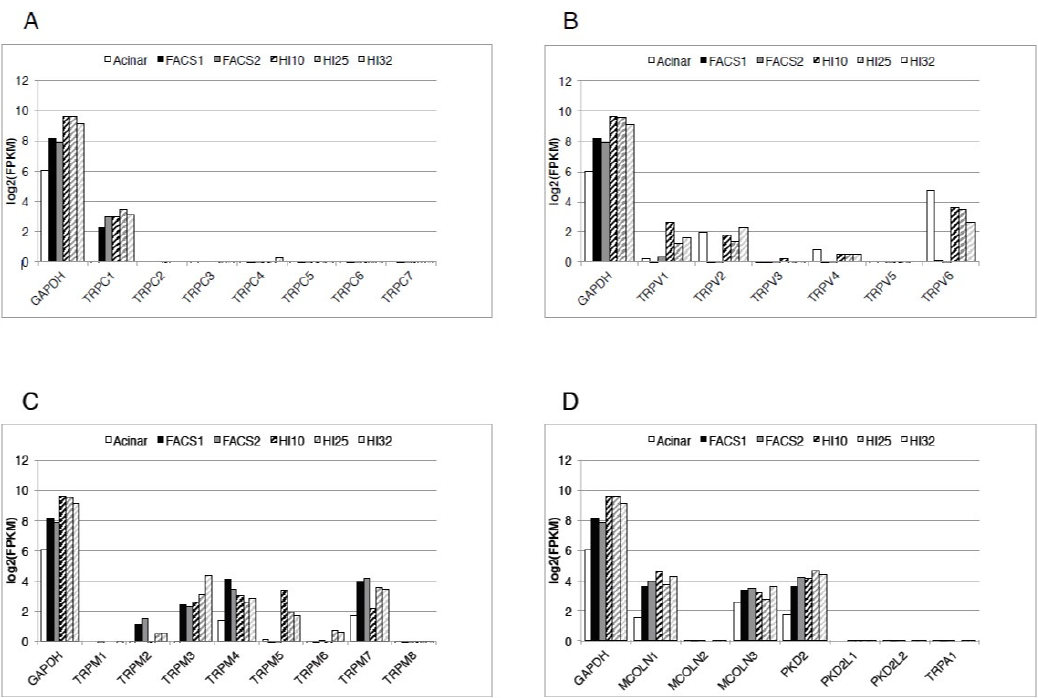
Figure 1. Expression of the transient receptor potential (TRP) channels in human β -cell and human islets. Expression levels are shown as bar plots on a log 2 (FPKM) scale. The bars in each group represent (from left to right) human pancreatic acinar cells; purified human β -cells preparations 1 and 2 (FACS1, FACS2); and human islet preparations HI10, HI25, and HI32. Relative levels of expressions of the channels of the TRPC family ( A ), TRPV family ( B ), TRPM family ( C ), and the remaining TRP channels (TRPA1, members of the TRPP, and TRPML families) ( D ), are shown. GAPDH expression is shown for comparison. A log 2 (FPKM) = 0 was considered as a minimum threshold for expression. MCOLN1 = TRPML1, MCOLN2 = TRPML2, MCOLN3 = TRPML3, PKD2 = TRPP1, PKD2L1 = TRPP2, PKD2L2 = TRPP3. FPKM = Fragments Per Kilobase Million. Reproduced with permission from [7], Marabita and Islam,